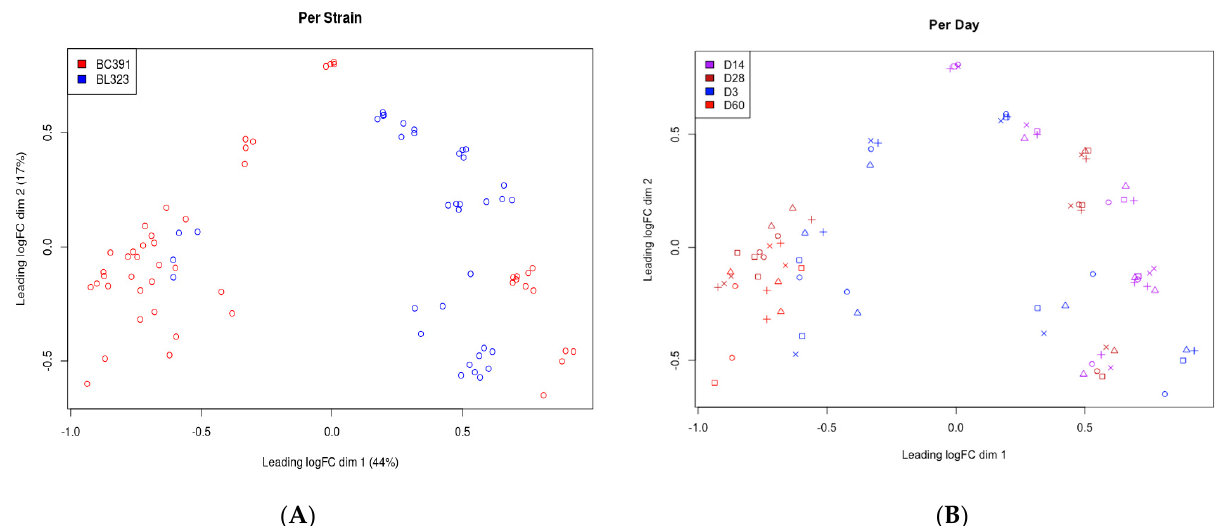
Figure 4. Multidimensional scaling analysis. See methods for details. ( A ) Graphical view of the variation of the data according to the strain type. Red circles correspond to gene expression data for strain BC-391. Blue circles correspond to gene expression data for strain BL-323. ( B ) Graphical view of the variation of the data according to the days post-infection. Each color represents the days post-infection as indicated by the conventions in the upper left box of the graph.